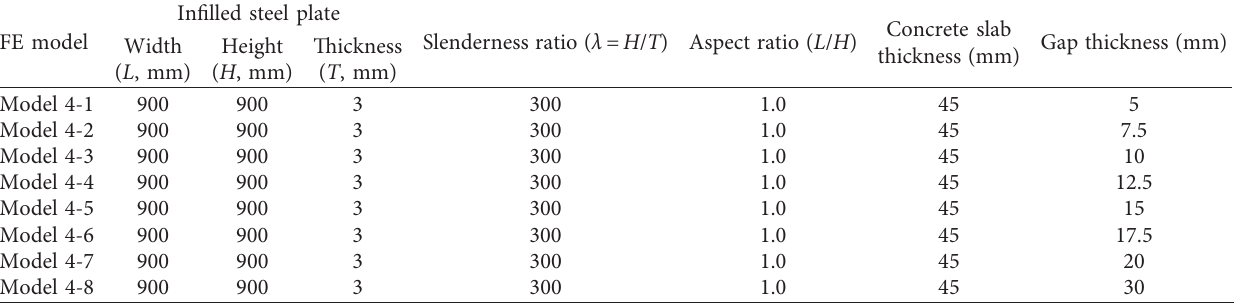
Table 12: Details of FE models (gap